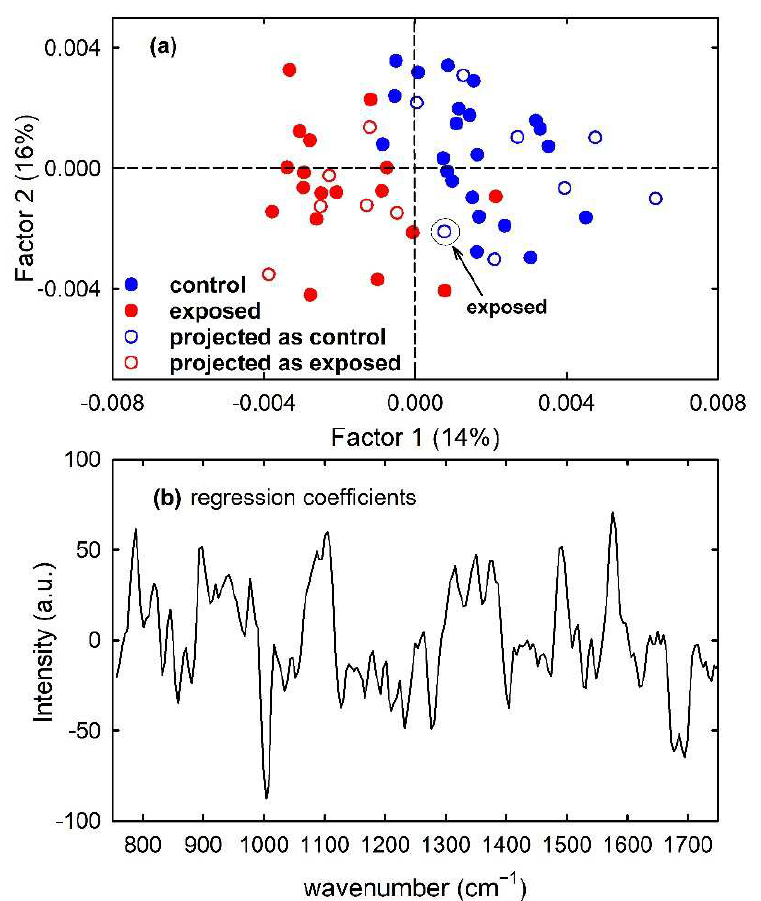
Figure 9. Scores plot (Factor 2 vs. Factor 1) of the developed PLS-DA model about Raman spectra for control (blue circles) and exposed (red circles) MCF10A cells, showing the calibration (filled circles) and projected test set (hollow circles) samples in ( a ). The root mean square error for cross-validation (RMSECV) is 0.75. One misclassified sample of the test set is enclosed inside a circle and labelled in ( a ). Regression coefficients for the PLS model with two components in ( b ).